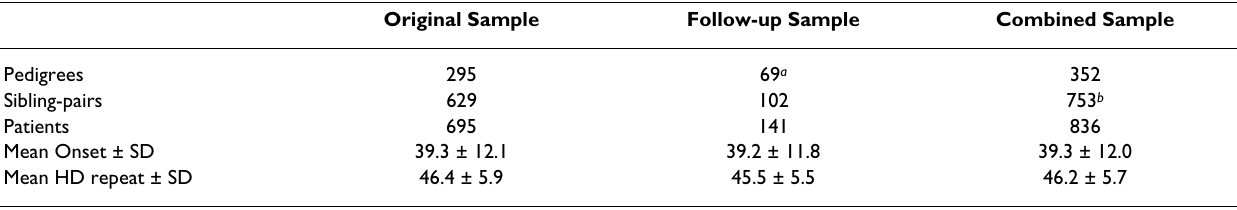
Table 1: The Study